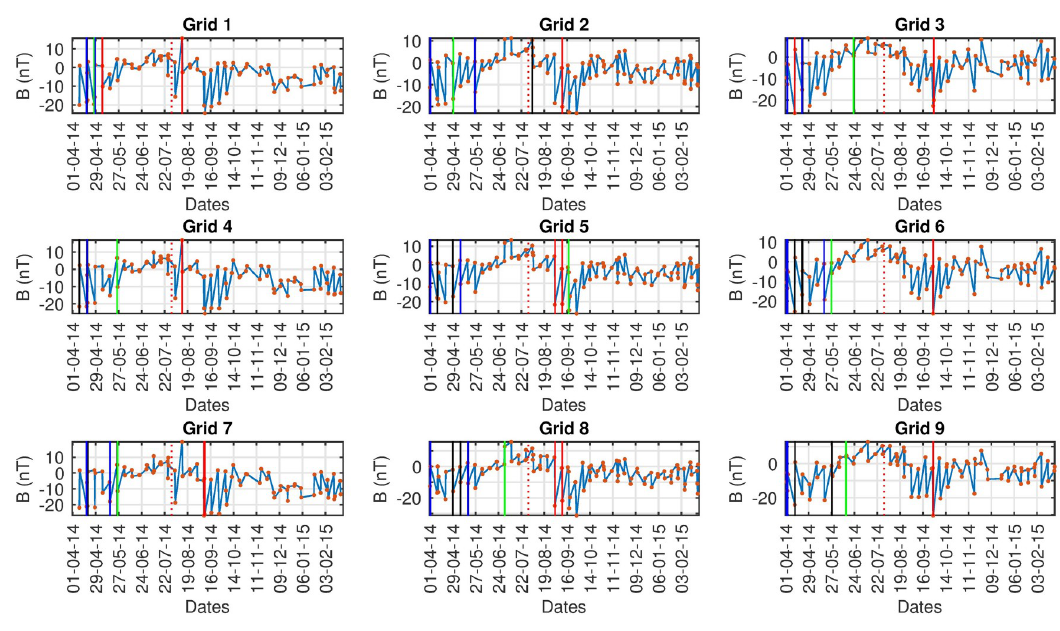
Fig 9. AD results Swarm B, red: CE , black: Fuzzy, blue: D-SAX , green: